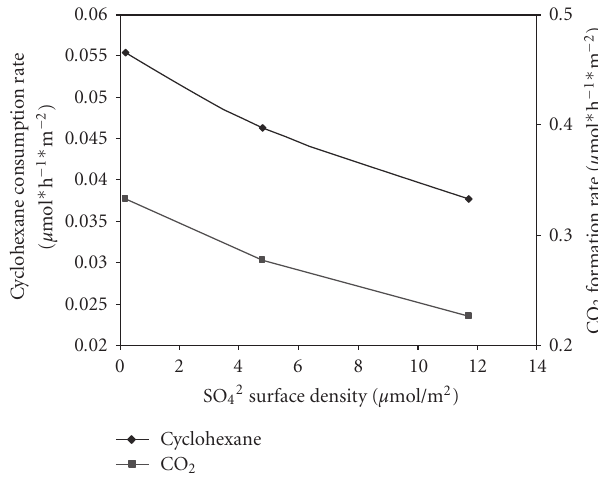
Figure 6: Cyclohexane consumption rate and CO 2 formation rate on PC500, PC500S10, and PC500S18 as a function of sulphate sur- face density.